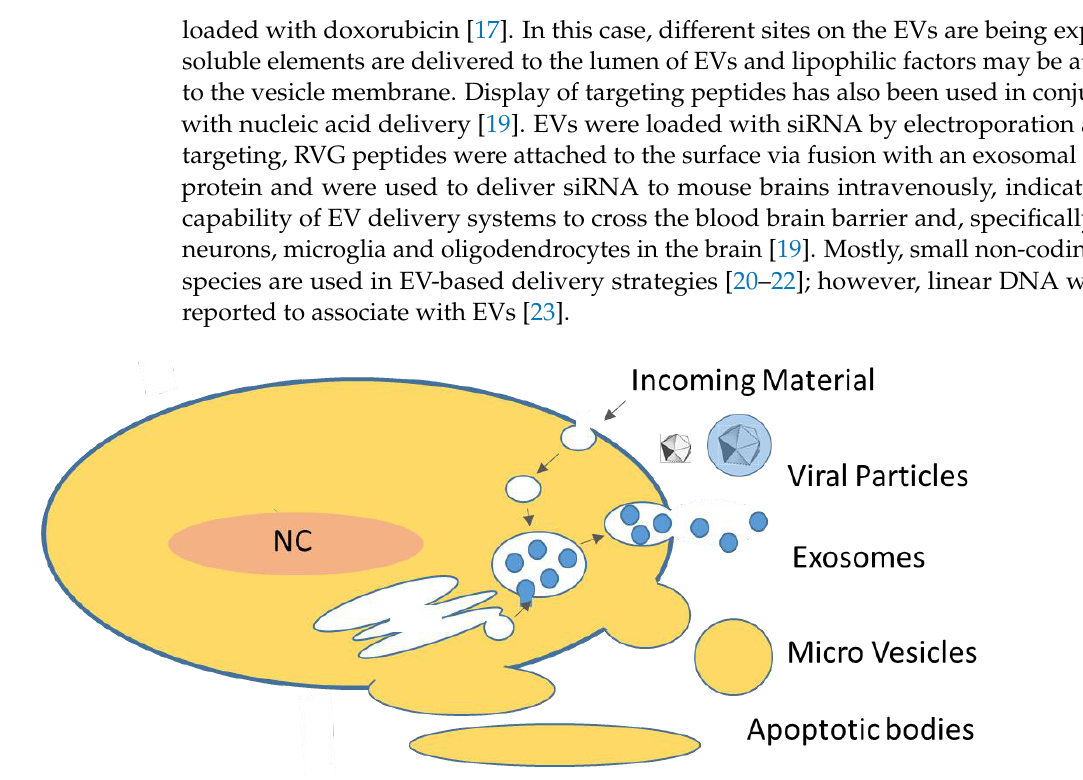
Figure 1. Overview of extracellular vesicles in eukarya: EVs are either produced by membrane shedding (apoptotic vesicles, micro vesicles) or via the endosomal system (a crude schematic of the endosomal system is indicated). Eukaryotic cells produce mainly exosomes, micro vesicles and, under apoptotic conditions, apoptotic vesicles. Exosomes are generated as intra-luminal vesicles (ILVs) in multi-vesicluar bodies (MVB). Incoming material refers to material taken up by cells, e.g., by endocytosis. Also, EVs are entering cells by these mechanisms. For more details see text and Table 1; modified from [24].